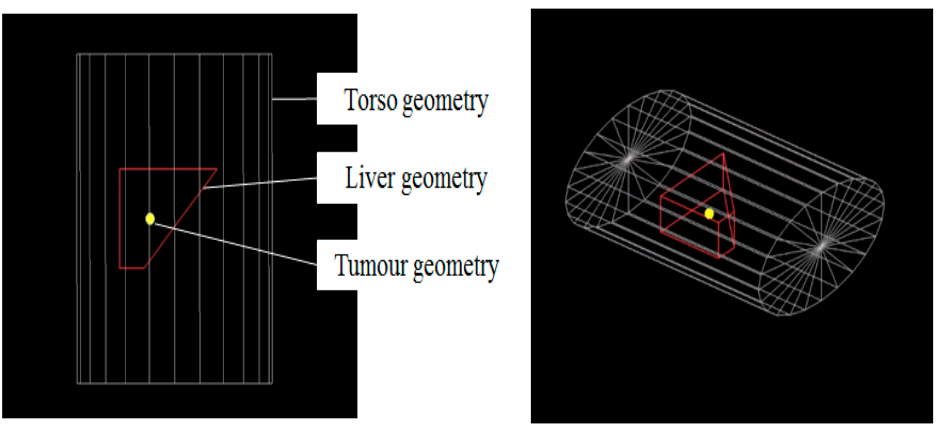
Figure 3. Geometrical configuration of the cylindrical torso phantom containing liver and tumour.